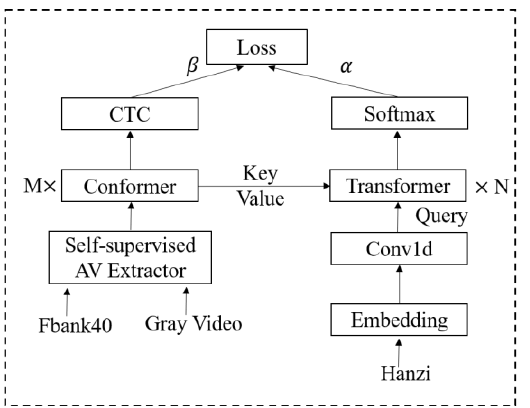
Figure 4. The AVSR system with pre-trained audio – visual representation .